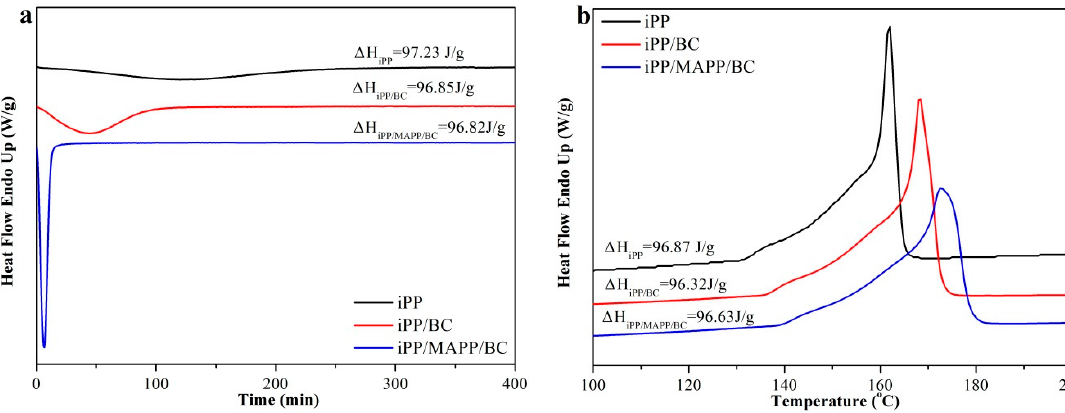
Figure 3. DSC curves of the iPP/BC hamburger composite ( a ) isothermal crystallization curve; ( b ) reheating curve).